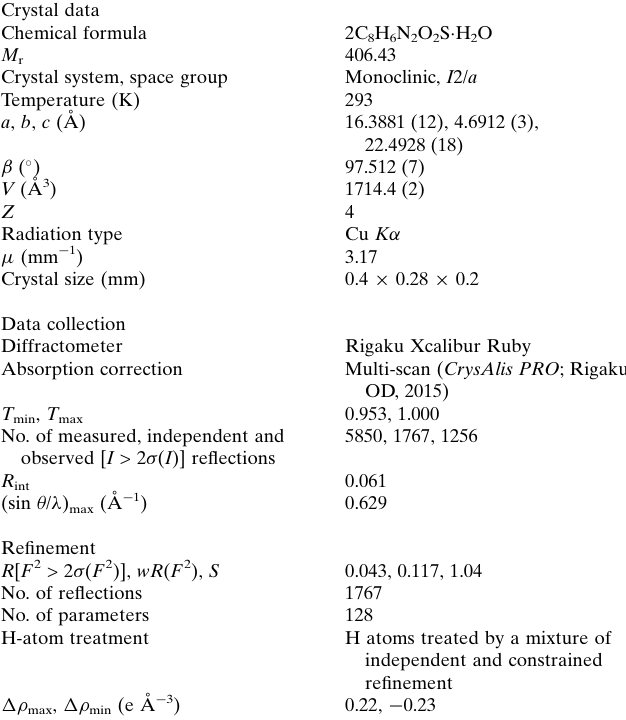
Table 2 Experimental details. Crystal data Chemical